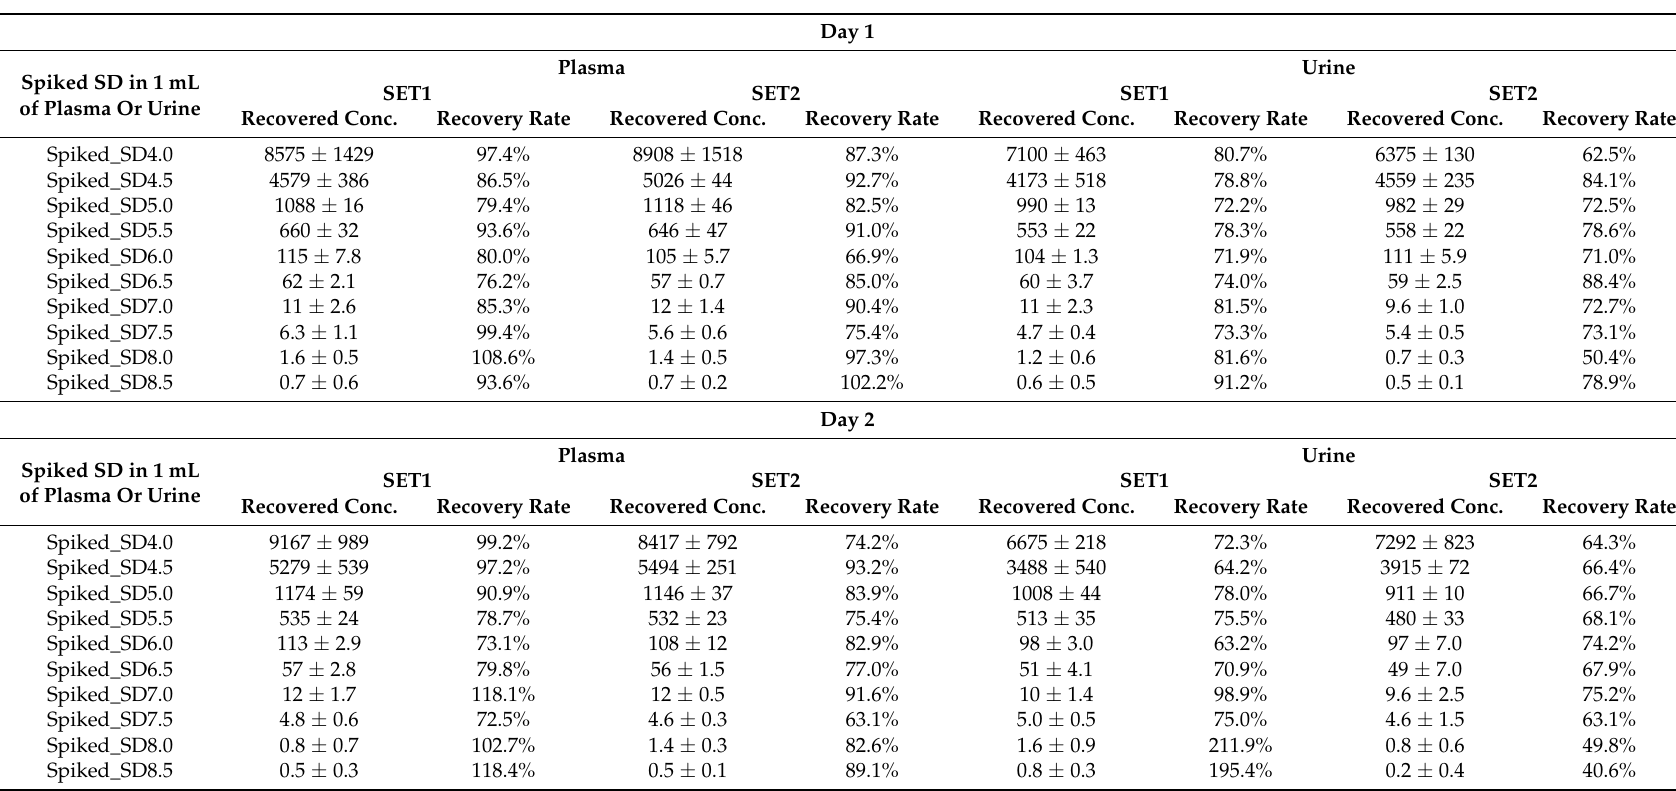
Table 3. Extraction efficiency of spiked plasmid DNA from EDTA collection tubes and